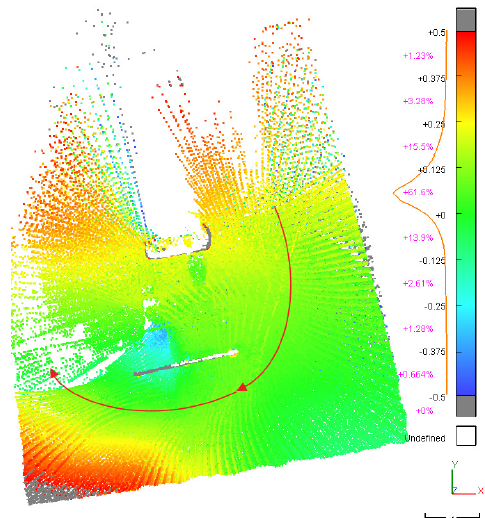
Figure 5. Vertical discrepancies between the TLS and MLS data acquired during cornering. The red arrowed line denotes the clockwise trajectory of the vehicle.